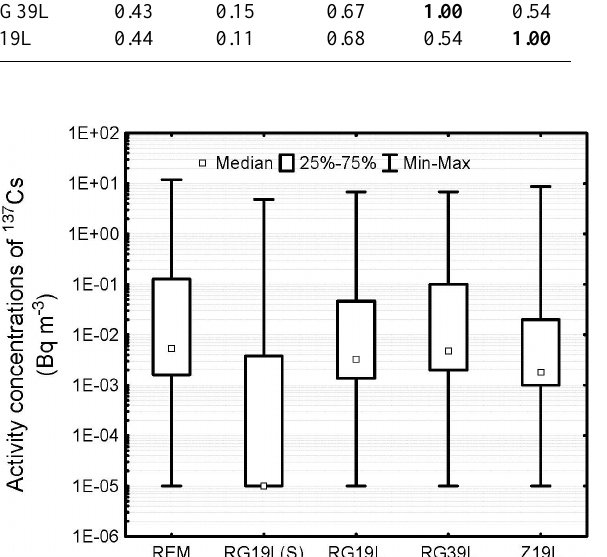
Fig. 8. Box & Whisker plots of the surface activity concentrations of 137 Cs obtained from the REM database and from the simula- tions using all the available versions of the model. The plot de- picts the smallest observation (sample minimum), lower quartile, median, upper quartile and the largest observation (sample maxi- mum) ( N =